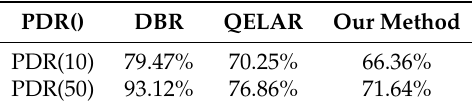
Table 2. Packet Delivery